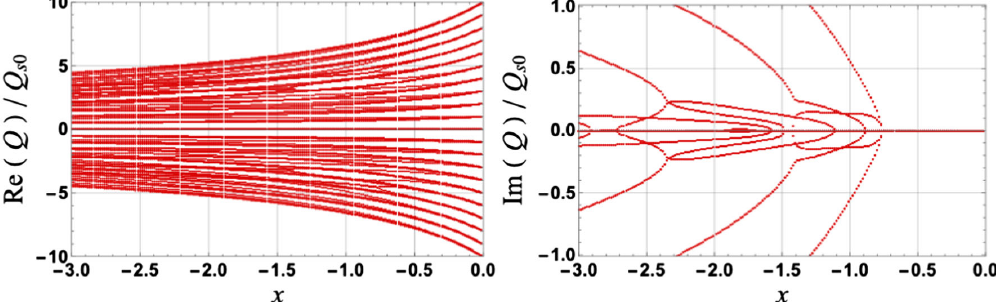
τ 2 . 8 ), above transition, taking into account the PWD such that f r r b ¼